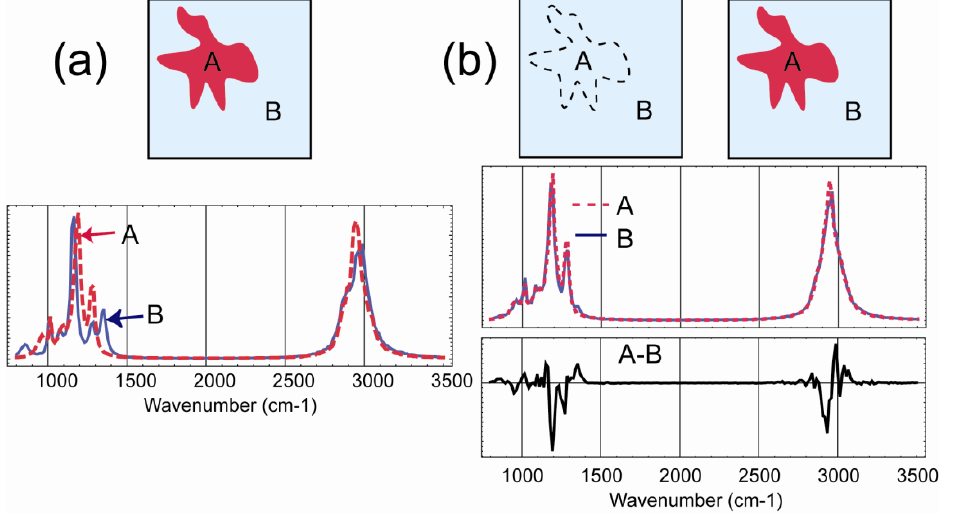
Figure 2. Comparison between absolute spectroscopic imaging and phenomenological imaging algorithm. In case (a), contaminated area A is spectrally distinguishable from B (substrate), and both are spectroscopically identified. The false color image (FCI) of (a)-top shows A and B being distinguishable by both algorithms. In case (b), A and B spectra are so similar that the absolute spectroscopic imaging does not make a distinction, yielding the FCI of (b)-left. However, the phenomenological algorithm detects a statistically significant difference in the A-B spectrum, and hence, can make a distinction in the FCI of